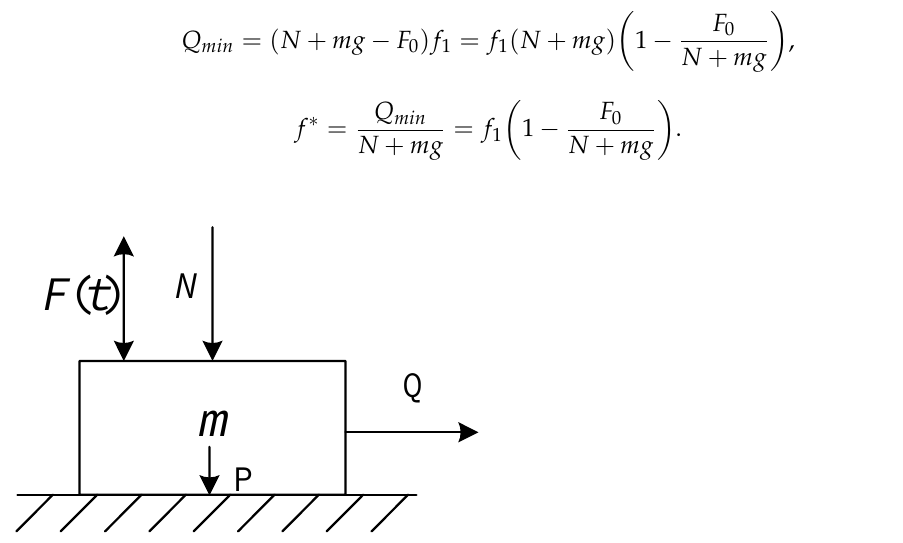
Figure 2. The vibration model of vertical force.